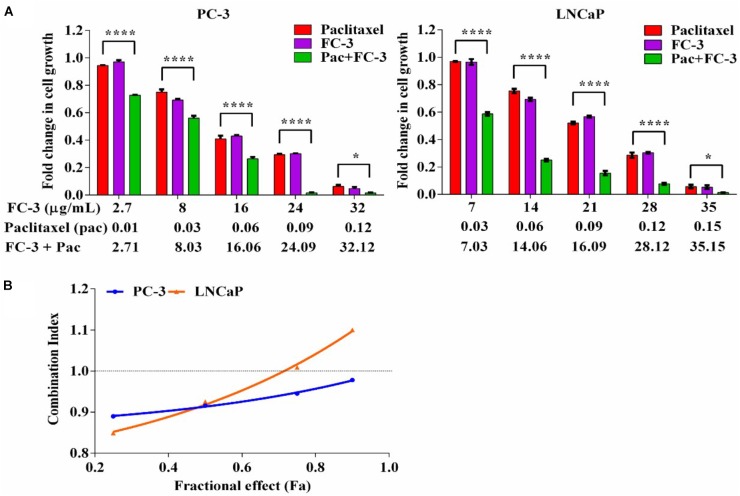
Combination effect of FC-3 and paclitaxel in prostate cancer cells (PC-3 and LNCaP). (A) Concentration-proliferation response graph, cells were treated with FC-3, paclitaxel, and the combination of both agents (molar ratio of the combination was IC50 FC-3: IC50 paclitaxel) for 72 h. Statistical analyses were done using two-way ANOVA followed by Bonferroni multiple comparison test with ∗p < 0.05, ∗∗p < 0.01, ∗∗∗p < 0.001, and ∗∗∗∗p < 0.0001, statistically different from paclitaxel treated cells (n = 3, mean ± SEM). (B) Combination index (CI) across the fraction affected (fa). The CI values were assessed using CalcuSyn software to determine the interaction (where CI > 1, =1, and <1 suggest antagonism, synergism, and additivity, respectively).